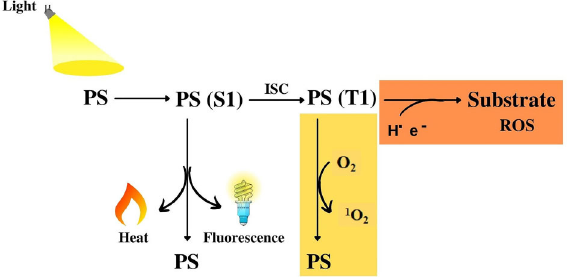
Figure 1. Photosensitization process. PS: ground state photo- sensitizer; PS (S1): singlet state photosensitizer; PS (T1): triplet state photosensitizer; ISC: intersystem crossing; orange box: type I reaction; yellow box: type II reaction.